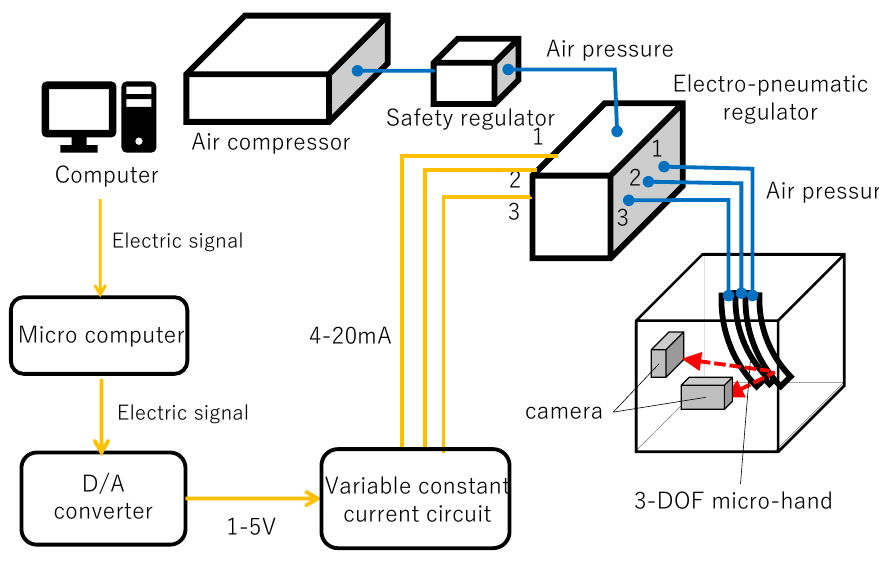
Figure 10. Experimental